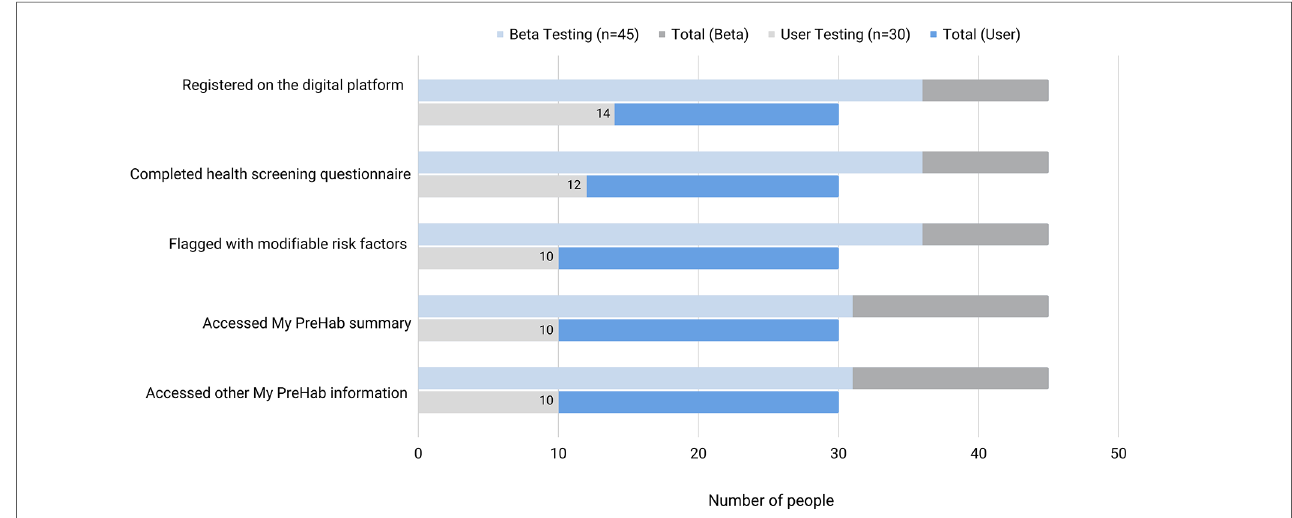
FIGURE 5 Consumer engagement with components of the My PreHab Pathway during user-testing and beta-testing in orthopaedic surgery.